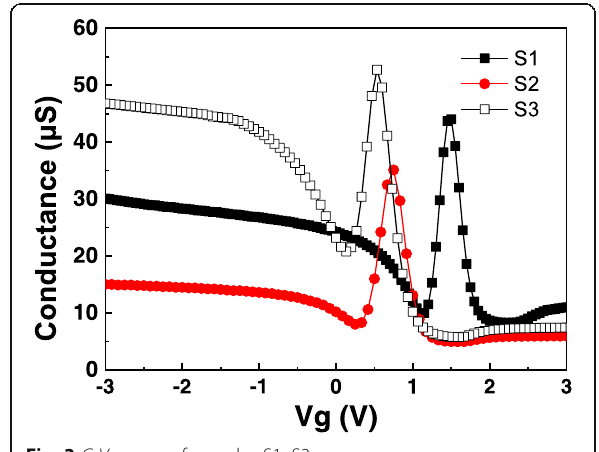
Fig. 3 G - V curves of samples S1 – S3